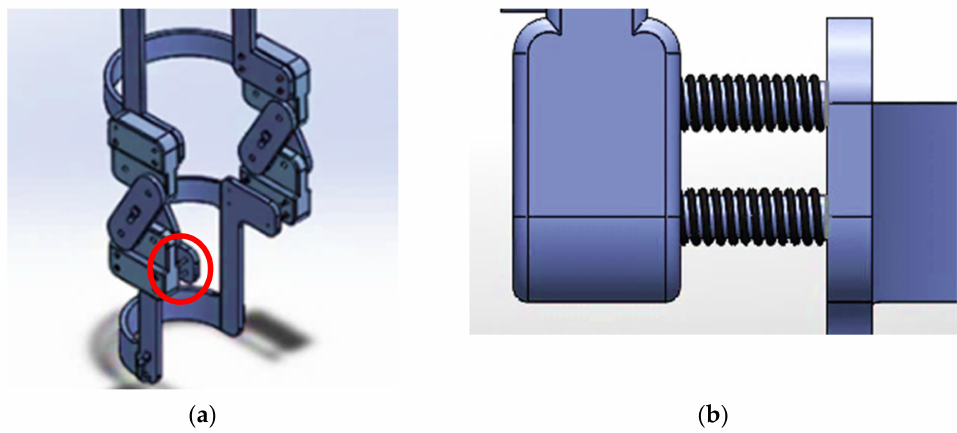
Figure 7. The final design of the exoskeleton ( a ) in its entirety and ( b ) a close up of the adjustable mechanism for leg